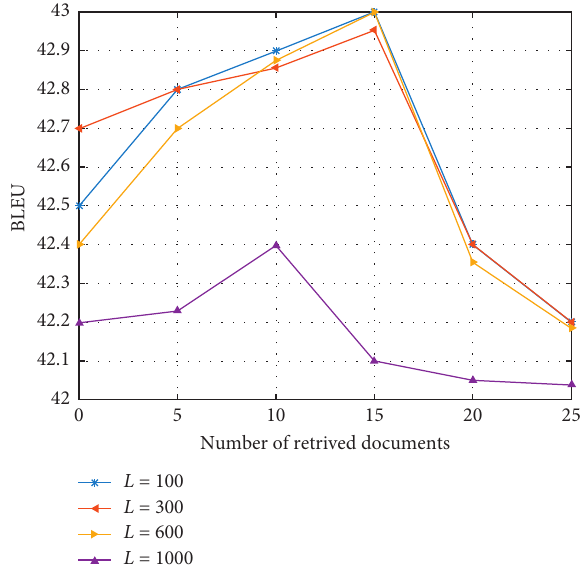
Figure 6: The effect of different number of retrieved documents and hidden layer length on machine translation accuracy.